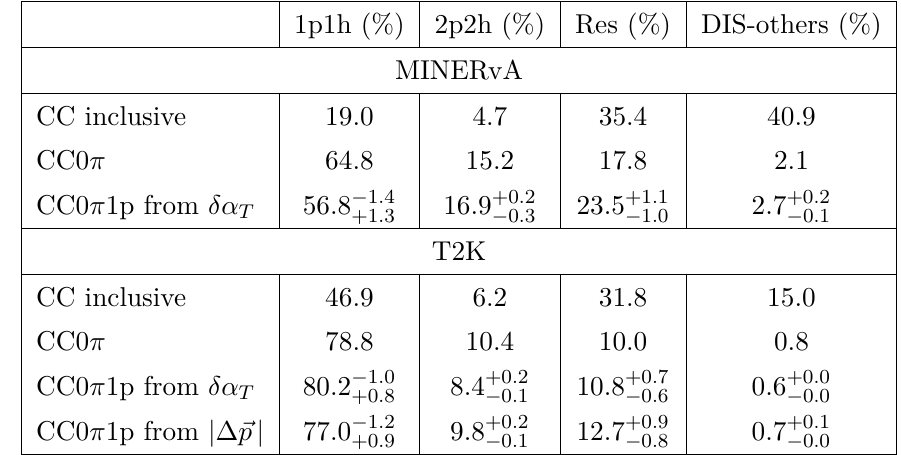
Table 6 . Different NEUT contributions to the T2K and MINERvA cross sections given in ta- ble 5. As in this latter table, the two T2K CC0 π 1p selections have been considered and all results are obtained using the nominal NrSP. For those samples with explicit proton in the final state (CC0 π 1p), we compute the variation of the proportions induced by the use of stronger or weaker proton re-scattering. The differences with respect to the results obtained from the nominal NrSP configuration are shown as an upper (NRsP 150%) and a lower (NRsP 50%) error. As expected, the increase (decrease) in the NRsP strength reduces (increases) the population of CC1p1h in the sample, affecting indirectly the proportions of the other modes.